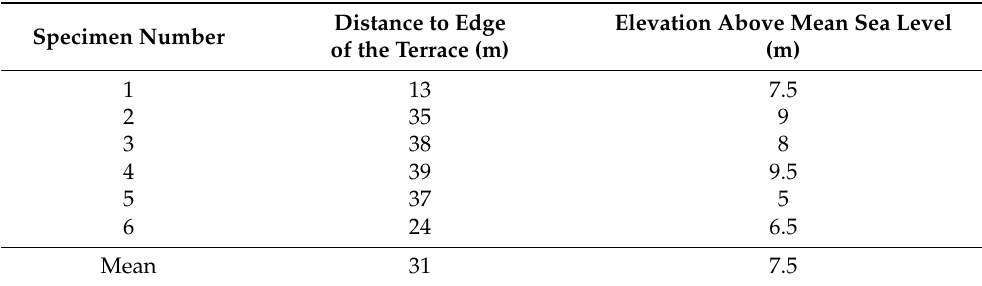
Table 2. Desiccated land plants represented by the Gulf Star Violet ( Stenotis mucronate) destroyed by exposure to seaward during Hurricane Kay on the 12 m limestone terrace at Arroyo Blanco on the eastern coast of Isla del Carmen in September 2022. Distance to Edge Specimen Number of the Terrace (m)